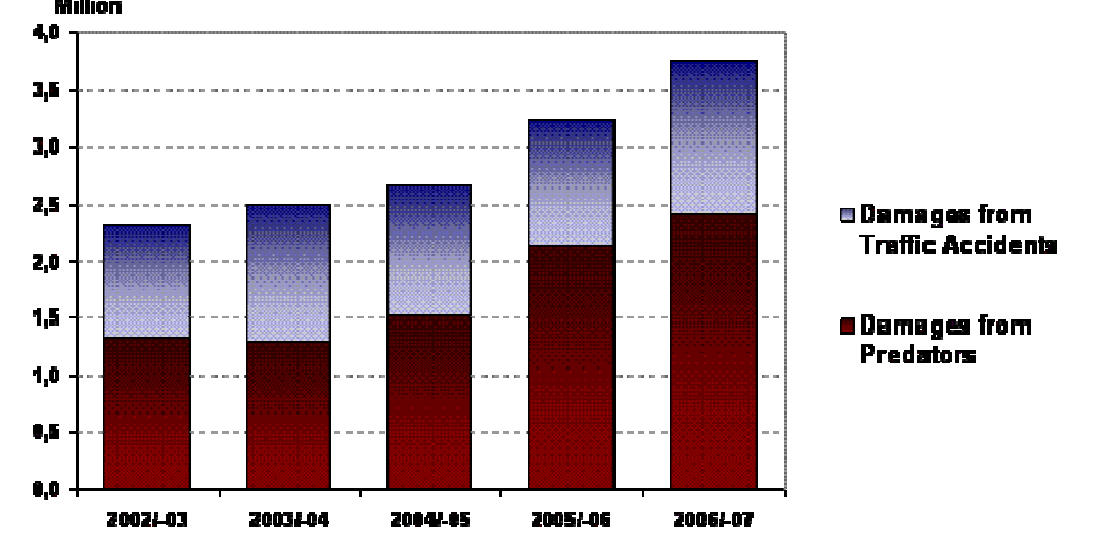
Fig. 2. The amount of compensations to the reindeer husbandry in 2002- 2007.